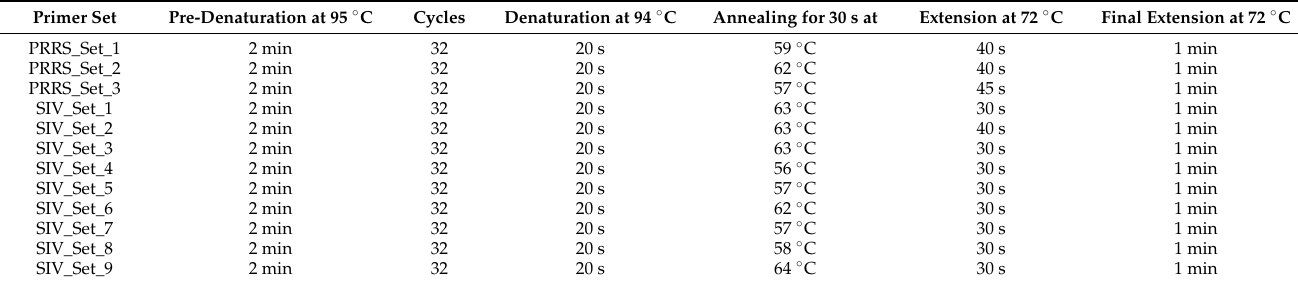
Table 2. Cycling conditions for each primer